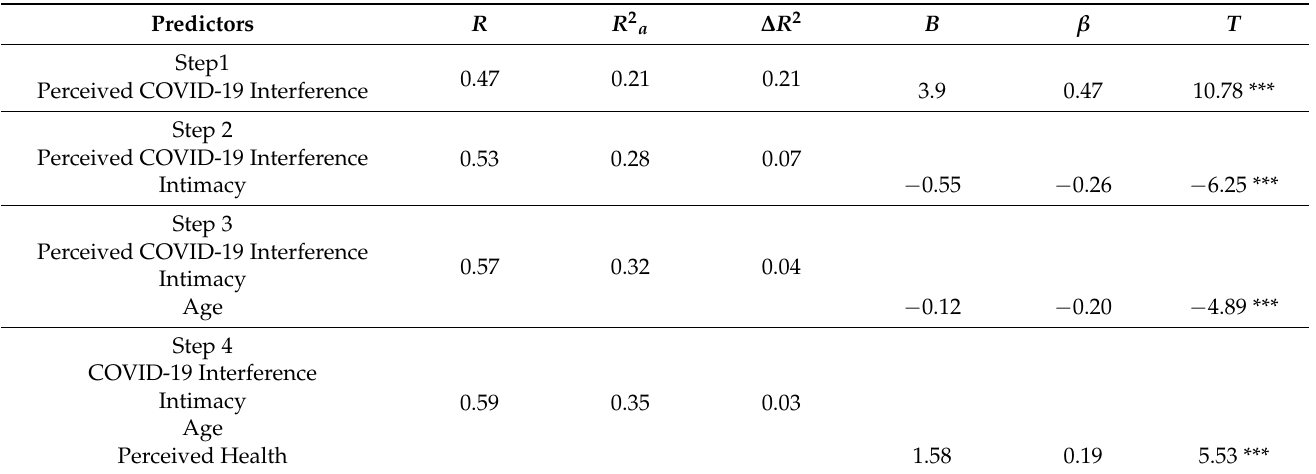
Table 5. Stepwise multiple regression analysis explaining